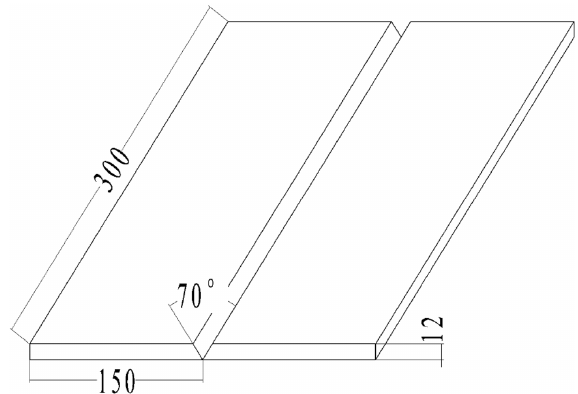
Figure 1: Square butt joints configuration (unit: mm).